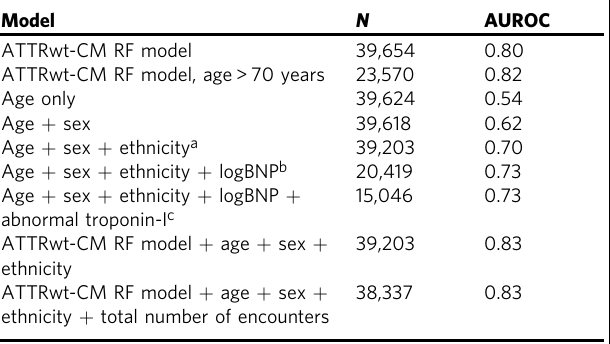
Table 4 Areas under the receiver operating characteristic curve for various prediction models in the Northwestern Medicine Enterprise Data Warehouse Heart Failure Cohort.